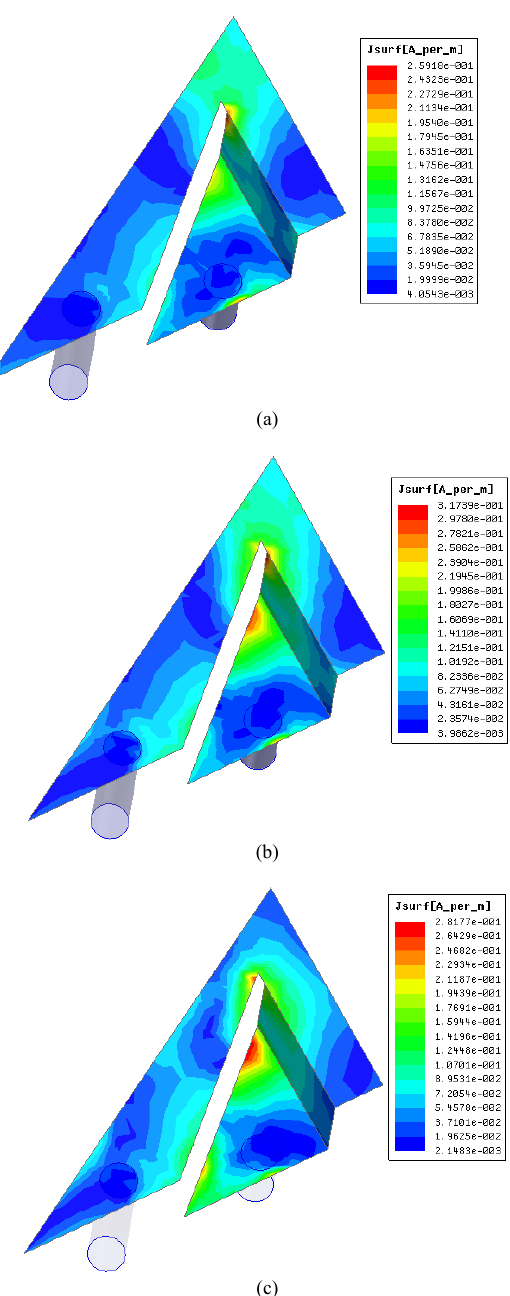
FIGURE 13 . Surface current density on the patch of the suggested half design at: (a) 4.9 (b) 8.1 (c) 15.5